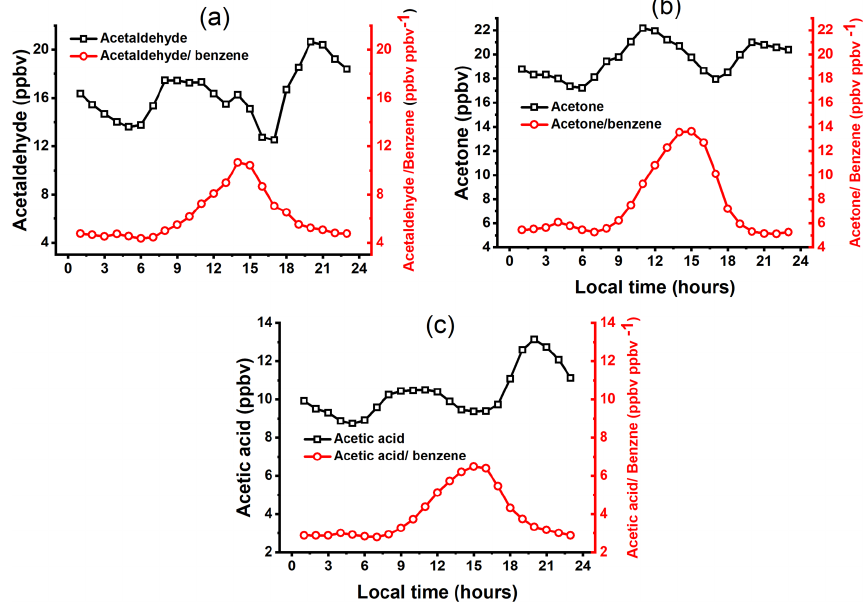
Figure 4. Diurnal variations over the whole study period for (a) acetaldehyde and the acetldehyde/benzene ratio, (b) acetone and the acetone/benzene ratio, and (c) acetic acid and the acetic acid/benzene